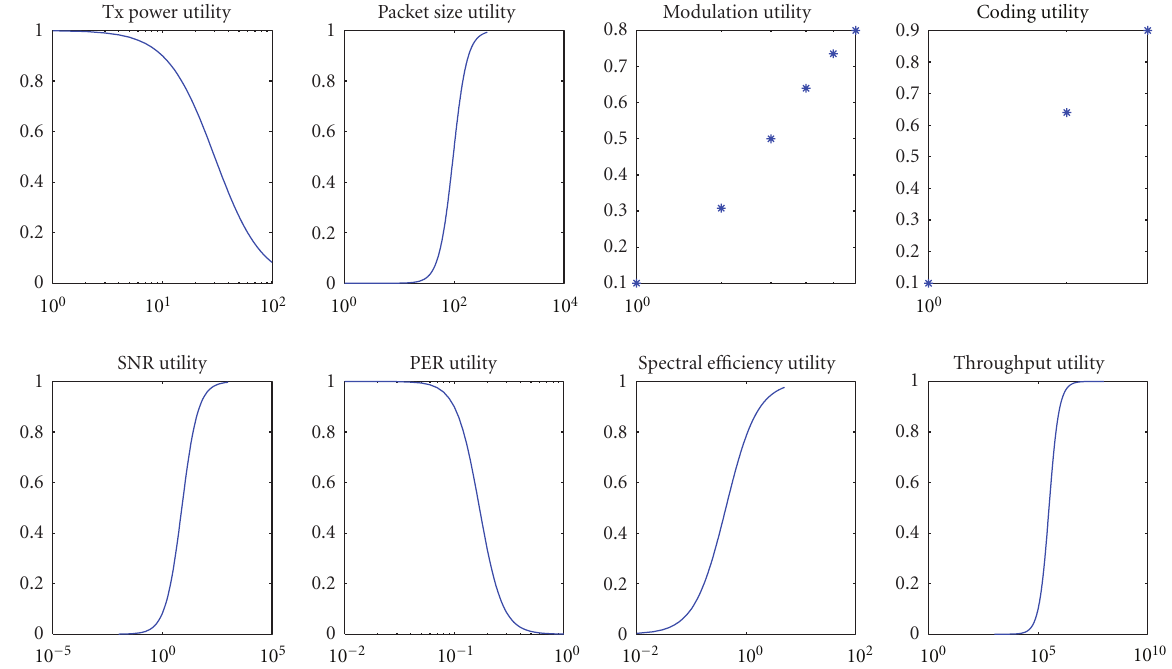
Figure 2: GA Utility functions— utility functions map the configuration parameters and meters onto a common scale between (0,1). A value of 0 is considered undesirable, while a value of 1 is considered most desirable. These utilities are adapted from previous work [1].